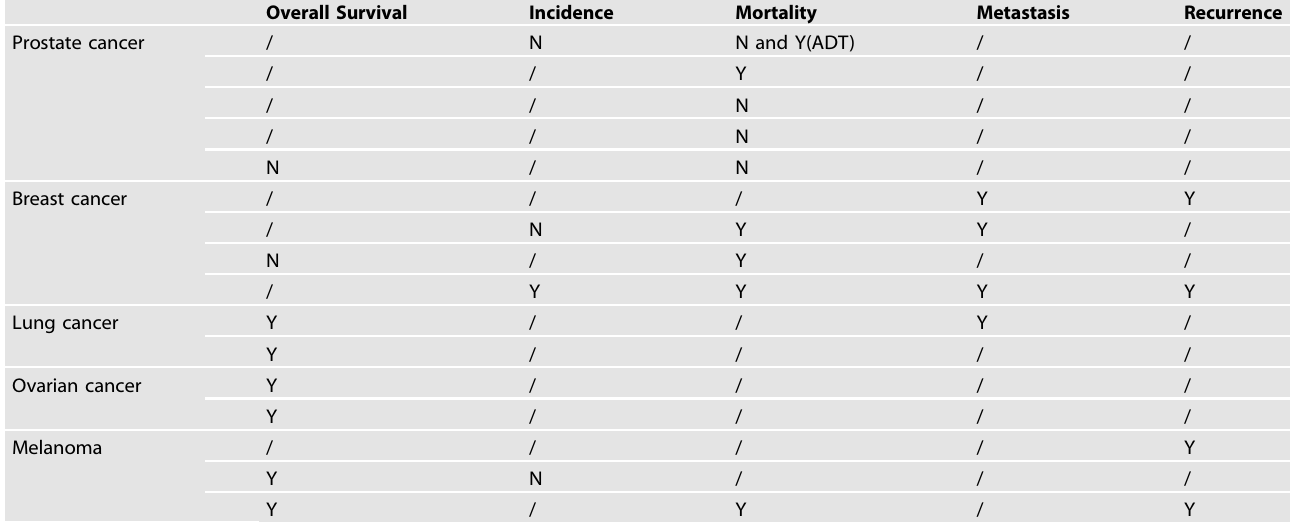
Table 2. Clinical application of targeting innervation.